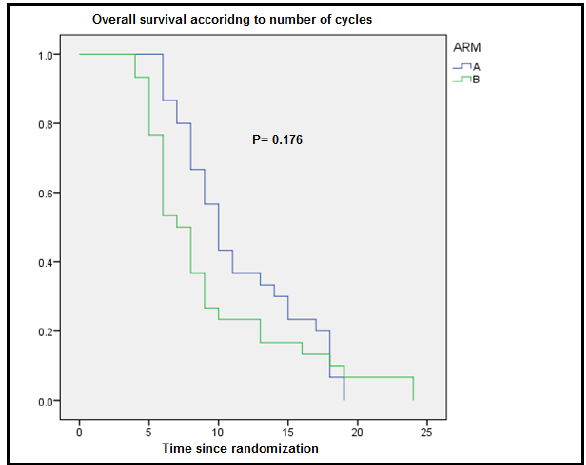
Figure-1: Kaplan-Meier overall survival curves according to number of cylces ( Arm A: 4 cycles; Arm B: 6 cycles